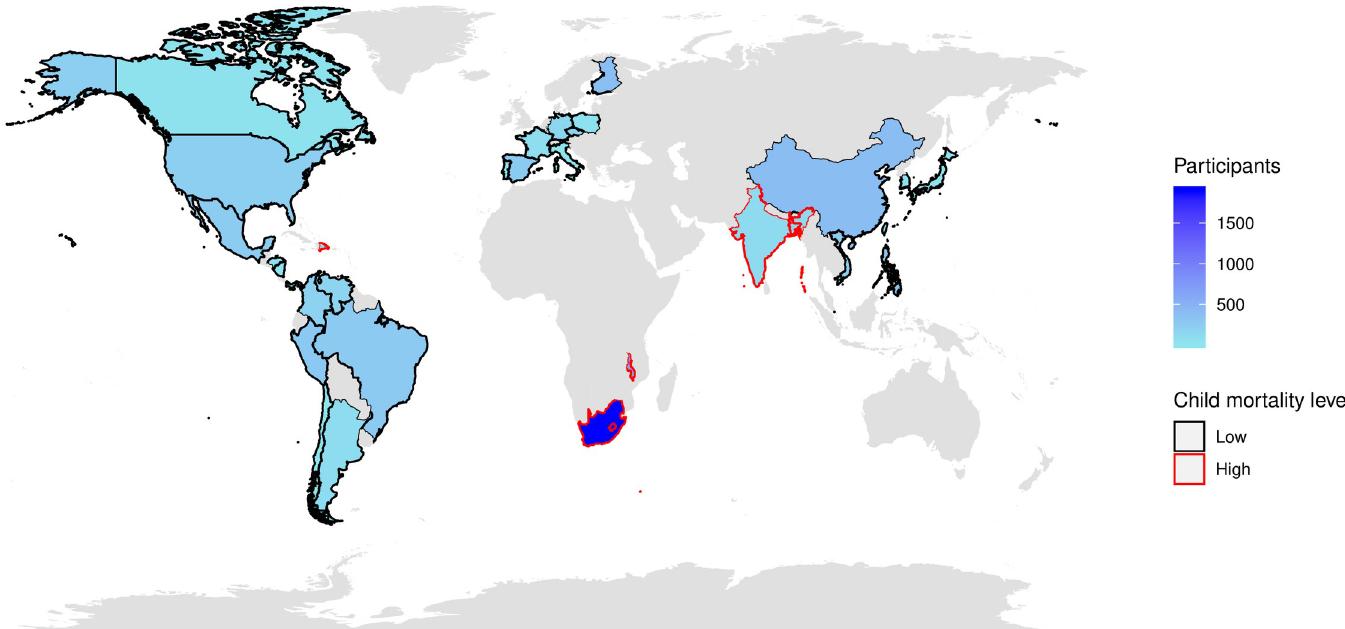
Fig 1. Clinical trial sites included in the analysis. Color shading represents the number of participants from each country. Country outline indicates a country’s child mortality classification (see S1 Table for details). For the primary analysis, countries categorized as “very low” and “moderately low” child mortality were combined and categorized as “low” child mortality. Map created using the “rworldmap” package in